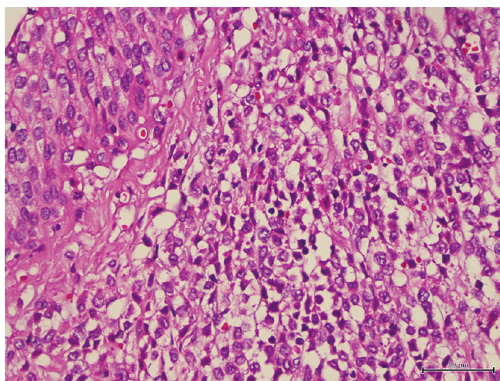
Figure 4: Neoplastic blasts located under the ureteral